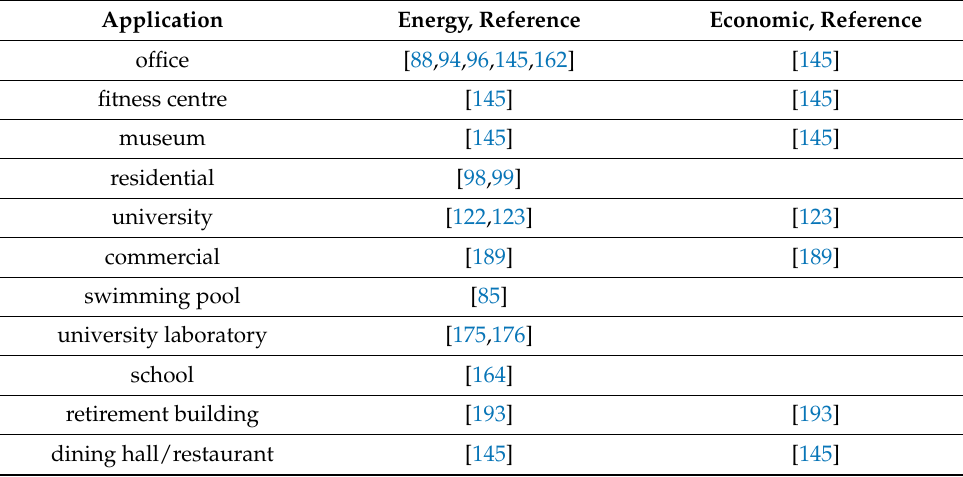
Table 3. Field tests on GEHPs: papers focusing on energy and economic analysis.